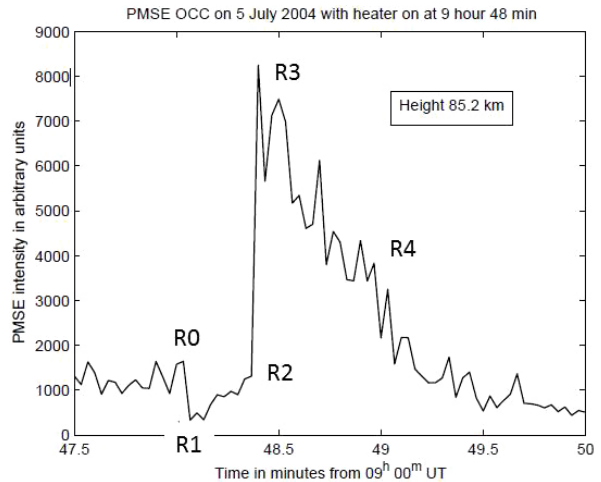
Figure 4. An overshoot characteristic curve (OCC) for VHF show- ing the backscatter sampling intervals R0, R1, R2, R3 and R4. The width of the sampling intervals can be changed. The heater is on from the start of the R1 interval to the end of the R2 interval. See text for